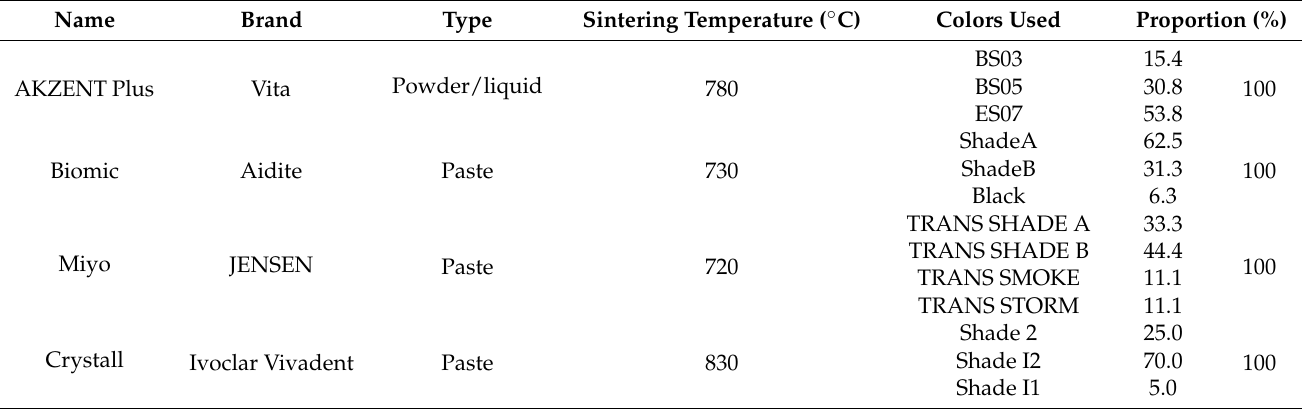
Table 1. Staining agent name, brand, and